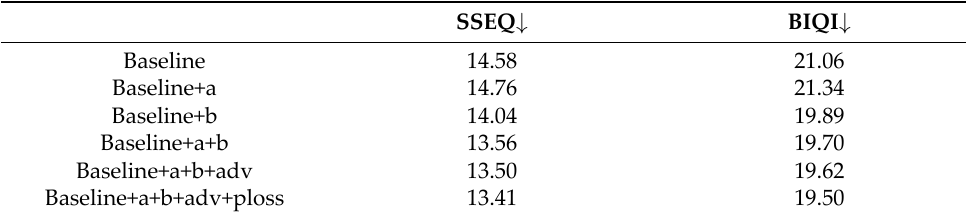
Table 1. Average SSEQ and BIQI scores for different